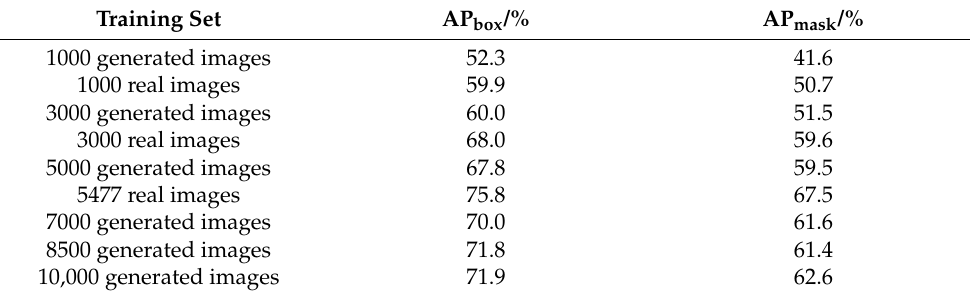
Table 2. Comparison of training effect between generated image and real